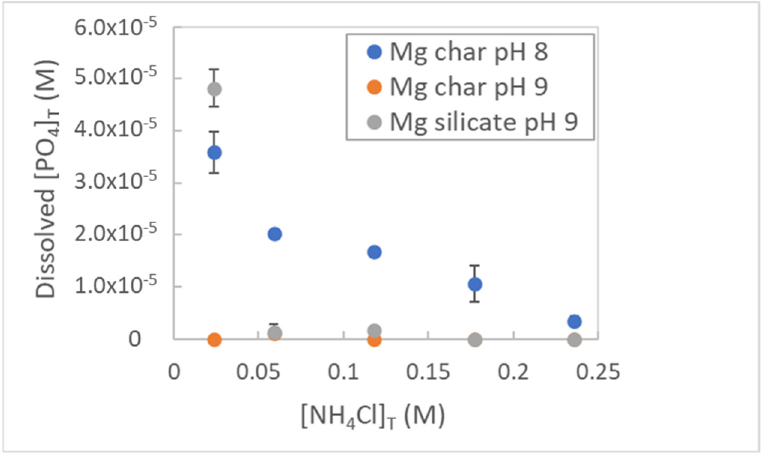
Figure 3. Dissolved [PO 4 ] T (measured) versus [NH 4 Cl] T . Error bars are standard deviations of the means of duplicate measurements.